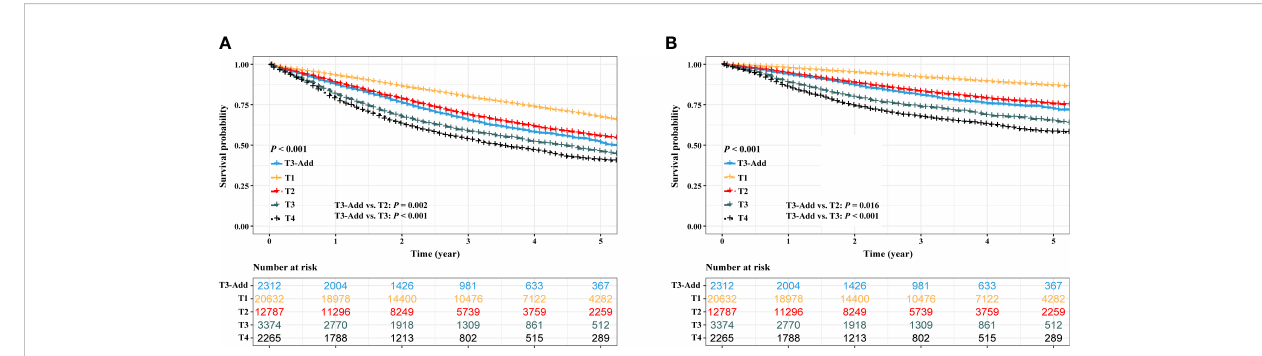
FIGURE 2 Kaplan – Meier estimates of survivals in the full analysis set. (A) overall survival: T3-Add vs. T1 vs. T2 vs. T3 vs. T4 and (B) cancer speci fi c survival: T3- Add vs. T1 vs. T2 vs. T3 vs. T4. T3-Add, T3 non-small cell lung cancer with additional tumor nodules in the same